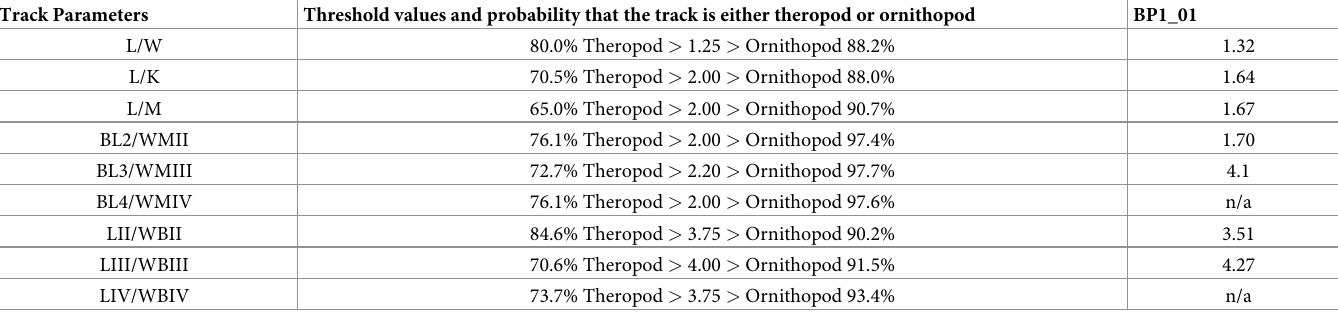
Table 4. Assessment of the trackmaker affinity of